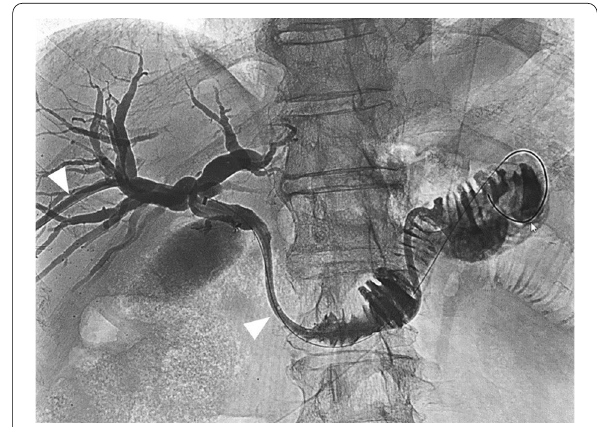
Fig. 1 Image of the right upper quadrant showing the 8,5Fr internal– external drainage catheter (white arrowheads) placed with its tip in the distal duodenum